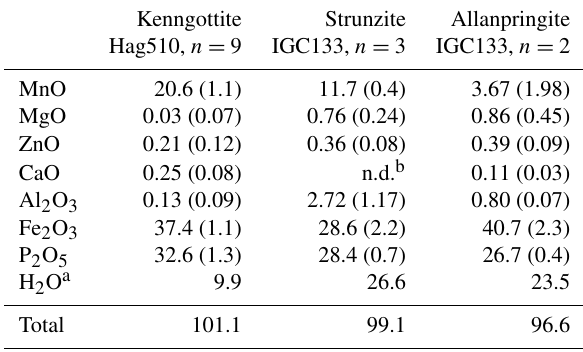
Table 1. EMP analyses with standard deviations in